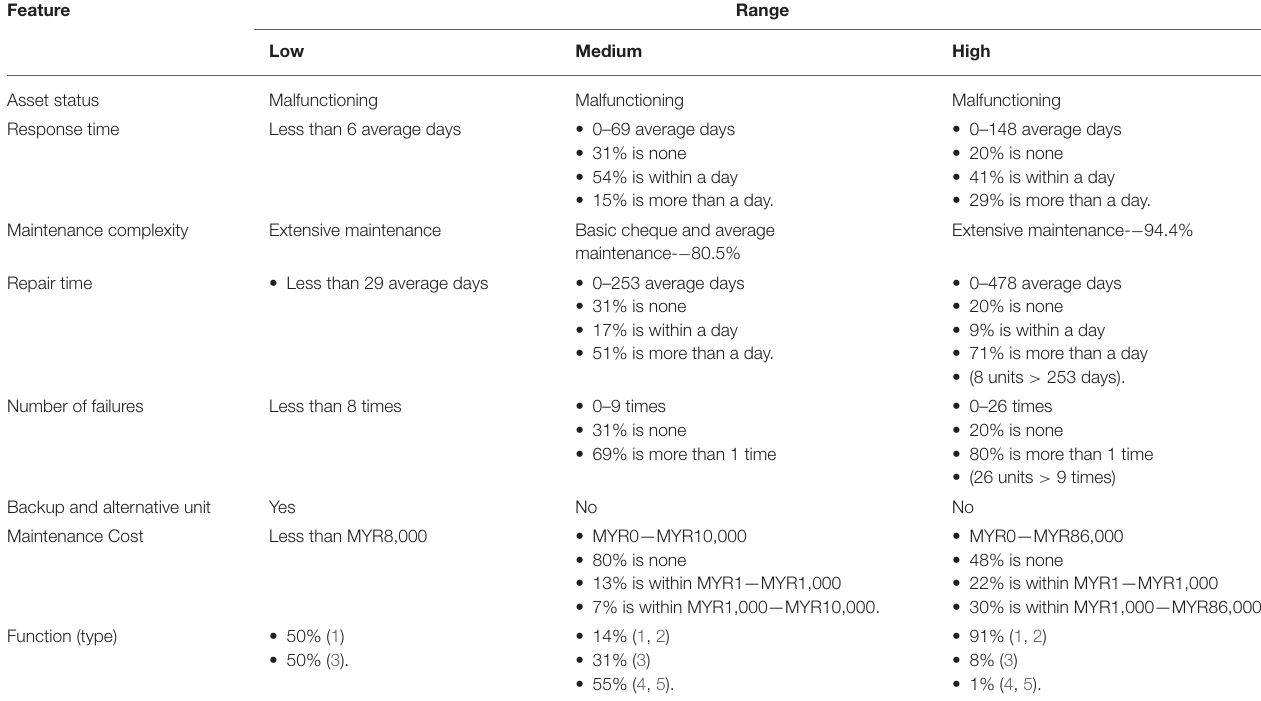
TABLE 8 | Findings of the corrective maintenance prioritisation system.